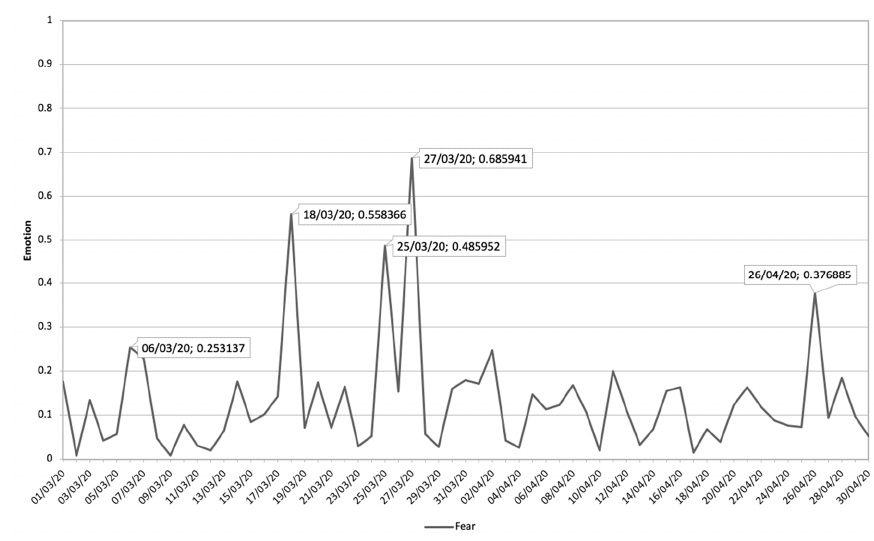
Figure 12. Sadness emotion during the period 1 March 2020 until 30 April 2020 related to terms about COVID-19.